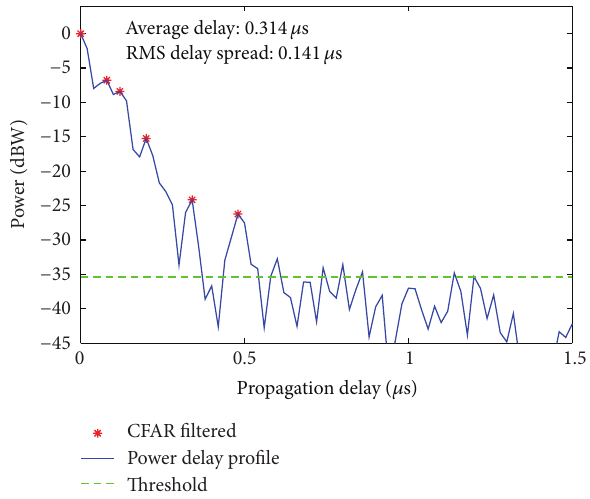
Figure 6: Measured power delay profile for building 5.